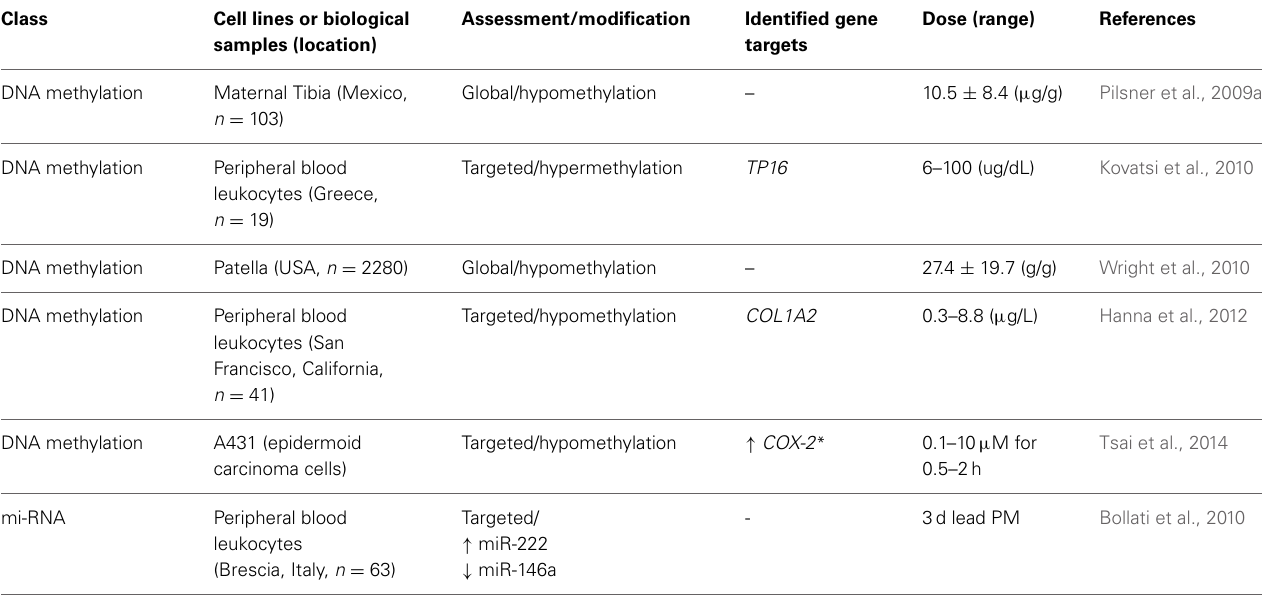
Table 3 | Epigenetic alterations induced by